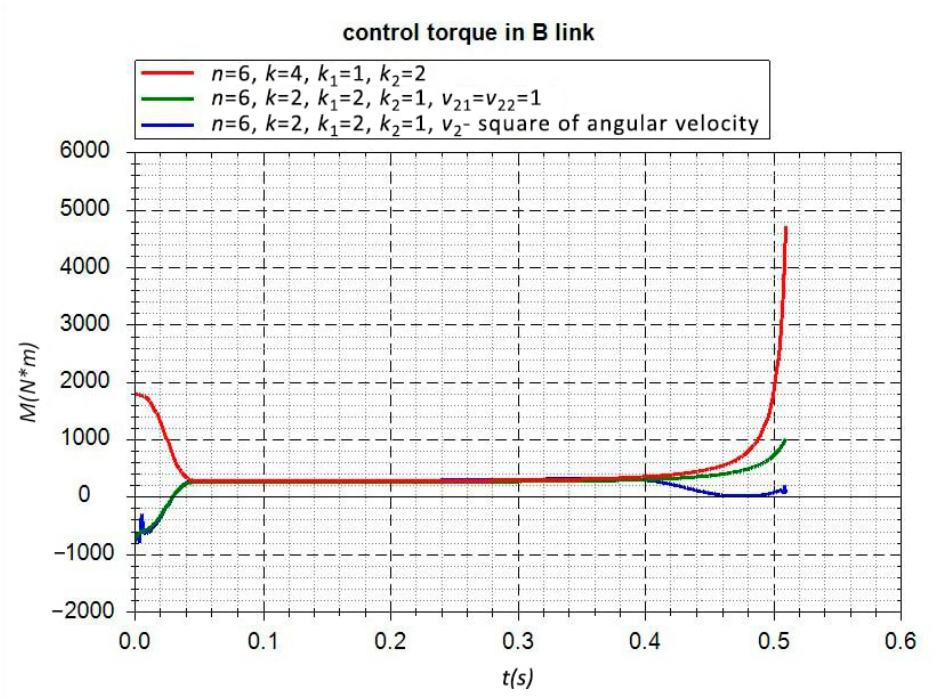
Figure 2. The control torque in link B when the horizontal movement of point A is free with various control